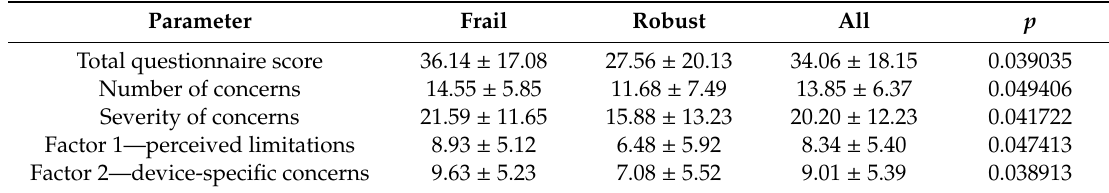
Table 3. Intensification of the concerns depending on the occurrence of frailty